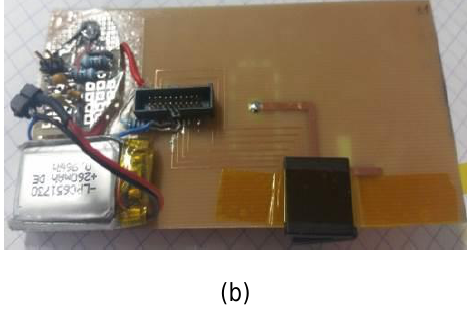
Figure. 4. Antenna structure (a) top view (b) bottom view